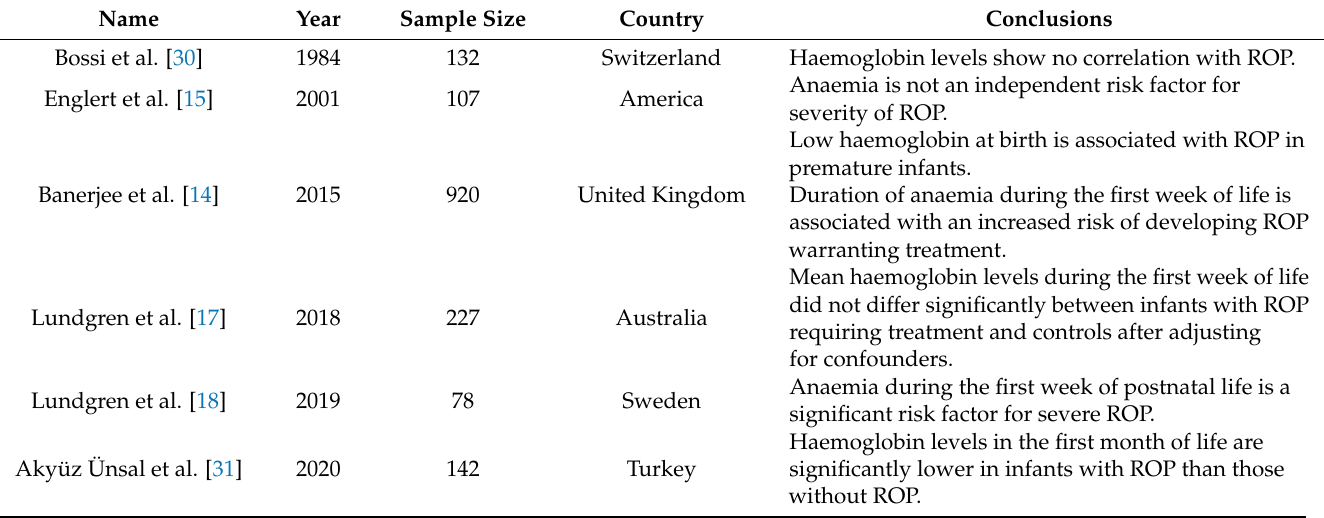
Table 4. Summary of literature associating haemoglobin with